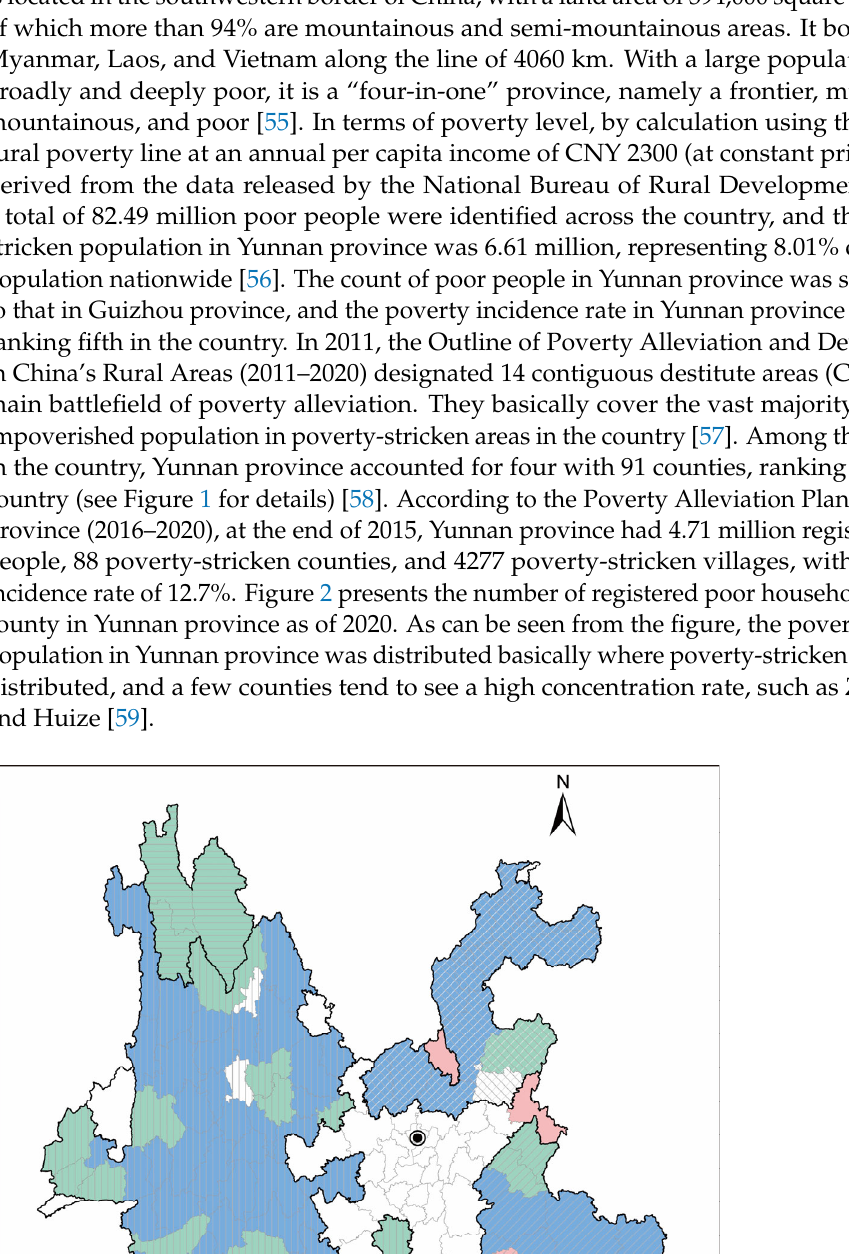
Figure 2. County ‐ level distribution of registered poor households in Yunnan in 2020.